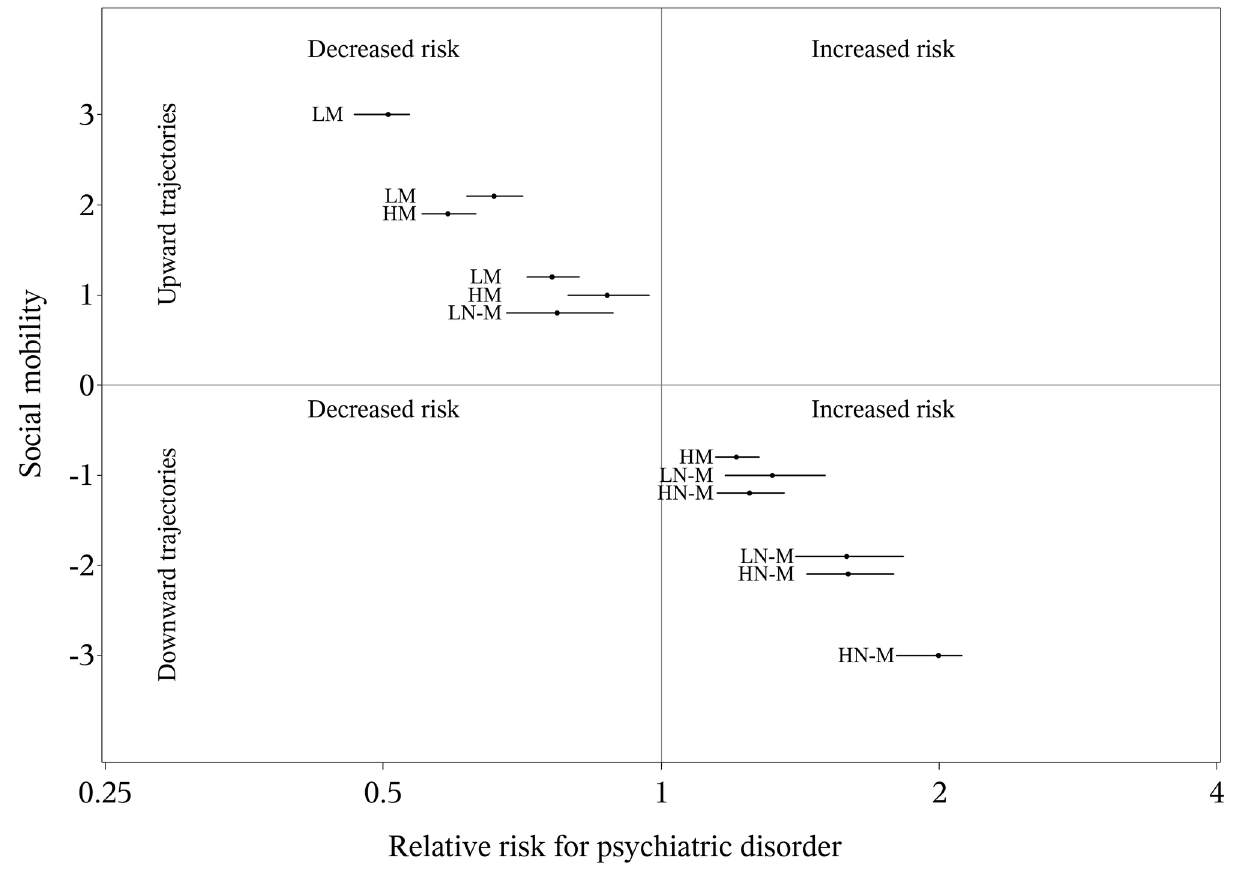
Figure 3. Relative risk (x-axis) of psychiatric disorder and two-sided 95% confidence intervals comparing different trajectories of social mobility (y-axis -3 to +3) versus subjects socially stable (stable between parent class to adult class; reference group). For each trajectory (-3, -2 ,..., +3) different relative risks presented for different parental class. Footnote: Trajectories start from high non-manual (HN-M) parental class, low non-manual (LN-M) parental class, high manual (HM) parental class, low manual (LM) parental class by upward (y-axis +1, +2 or +3) and downward mobility ( y-axis -3, -2, -1) with their corresponding RRs and 95% CIs. Subjects=798 660; psychiatric patients:19 533. doi: